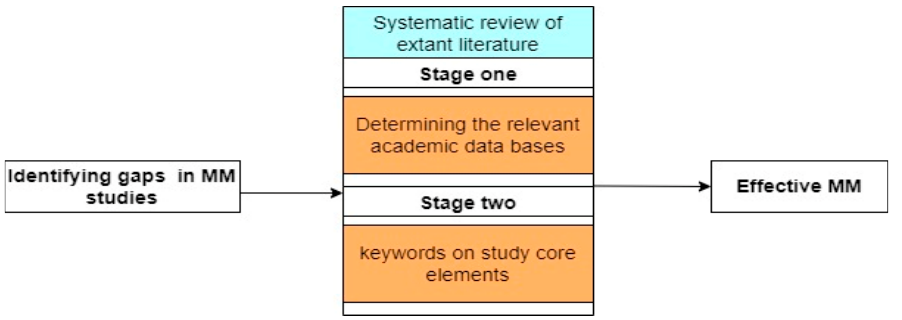
Figure 1. Research methodology adopted for the systematic review.